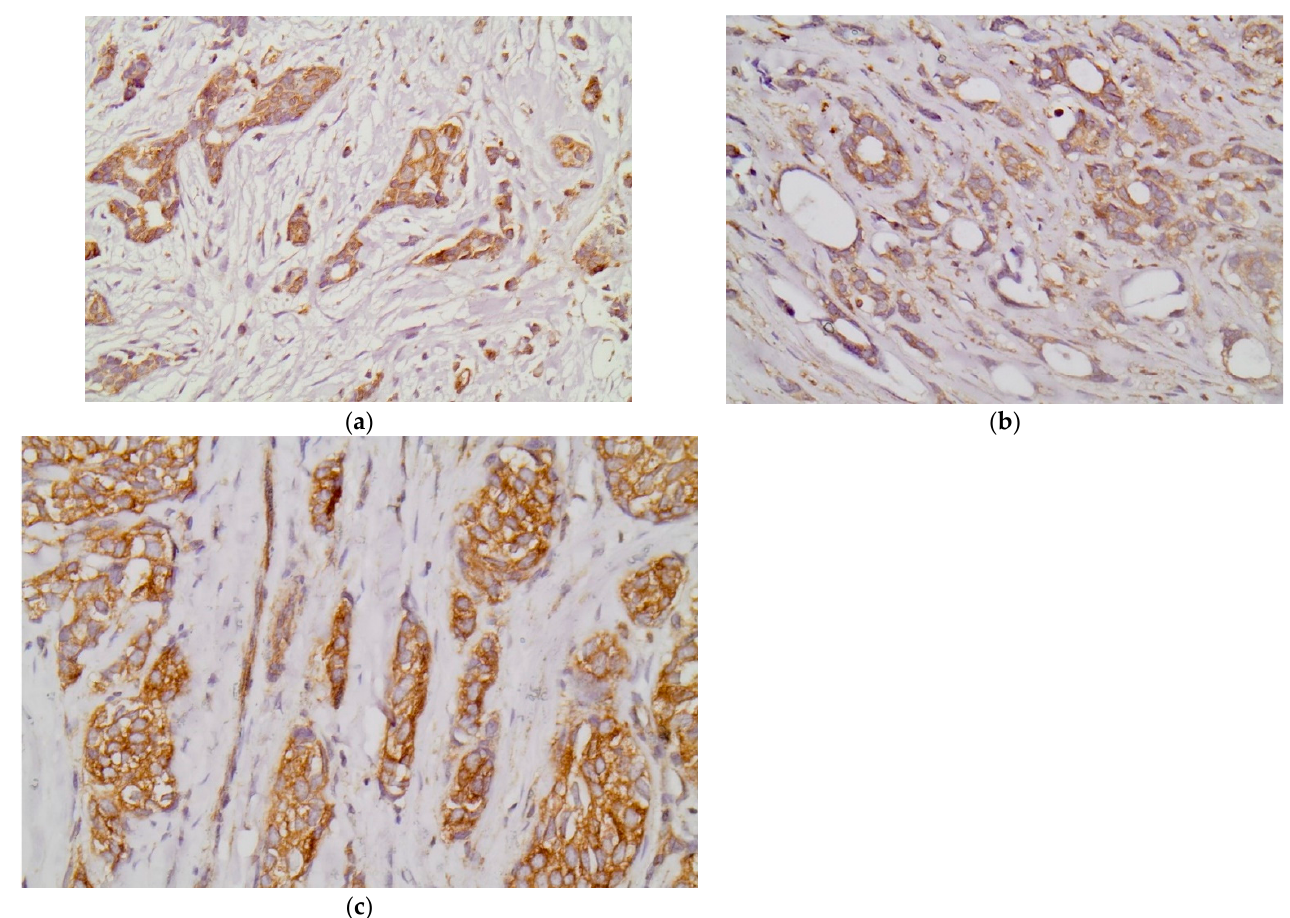
Figure 1. Representative positive immunostainings for EPHA2 ( a ), EPHA4 ( b ), and EPHA7 ( c ) in selected triple-negative breast cancer samples (200×).